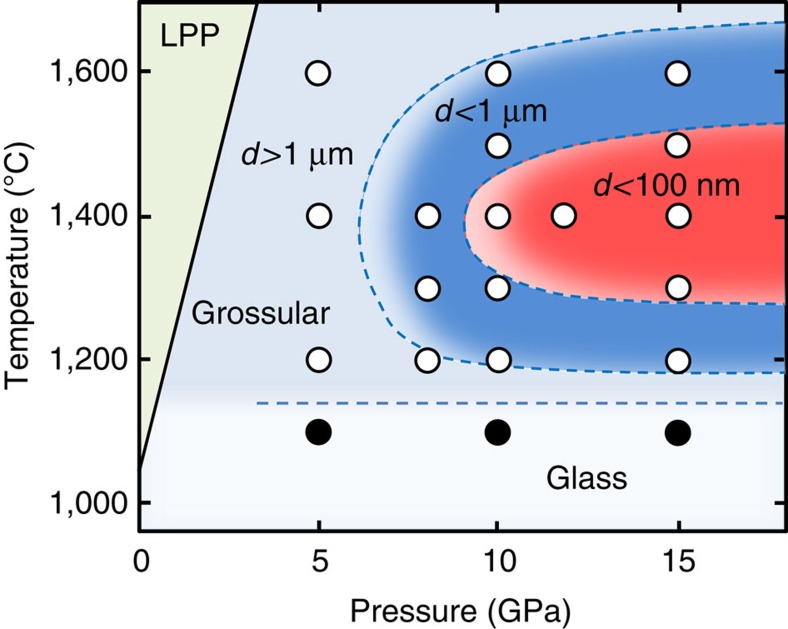
Pressure and temperature conditions for the synthesis of grossular.Polycrystalline grossular with grain sizes <1 μm is shown in the blue region. Highly transparent nano-polycrystalline garnet was obtained only in the red region at around 1,400 °C and at pressures at and above 10 GPa, while the samples remained glass at 1,100 °C. Note that these results on the grain size may change with the heating time, and the dotted boundaries are applicable to the runs with 2 h heating at the given pressures and temperatures. LPP, low-pressure phases (anorthite, gehlenite and wollastonite) of grossular38.